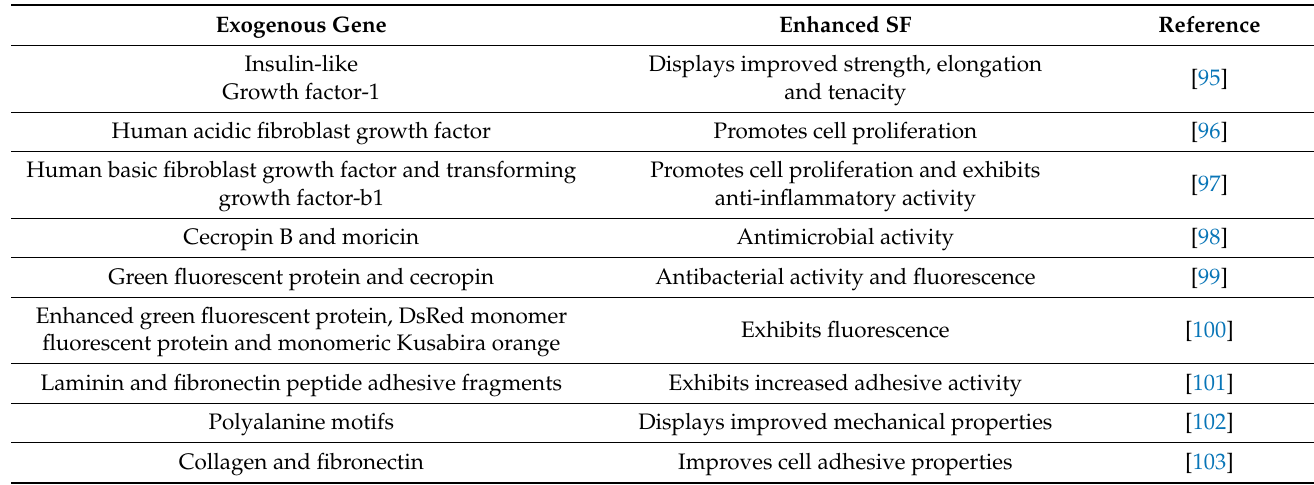
Table 2. Advances in genetically manipulated B. mori for obtaining enhanced SF.